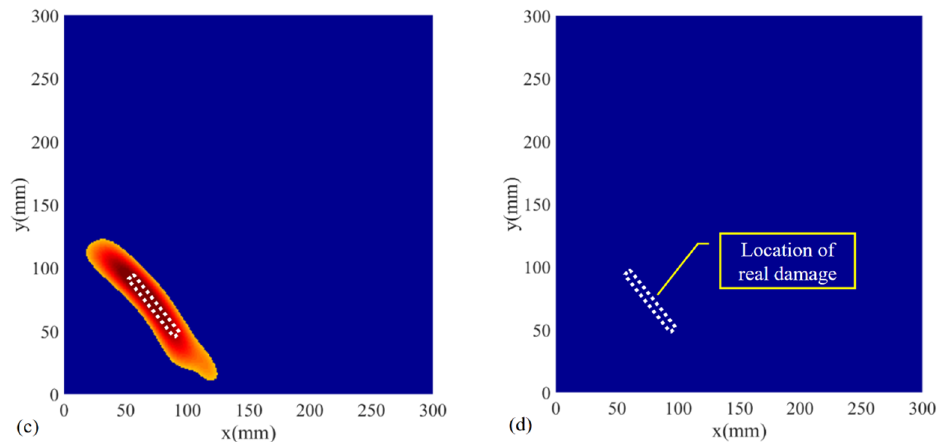
Figure 10. Damage imaging under various frequencies and cases: ( a ) 50 kHz using mobile transducer; ( b ) 80 kHz using mobile transducer; ( c ) 120 kHz using mobile transducer; ( d ) 50 kHz without using a mobile transducer.